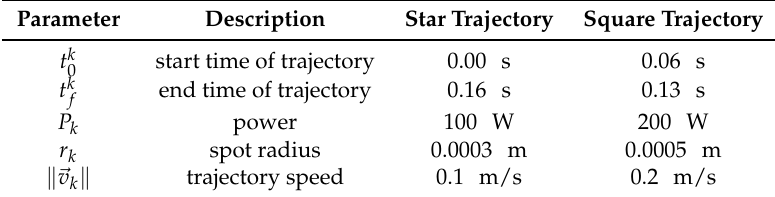
Table 2. Parameters for the simultaneous laser heating trajectories of Figure 3a (similar to [14,31,35]).